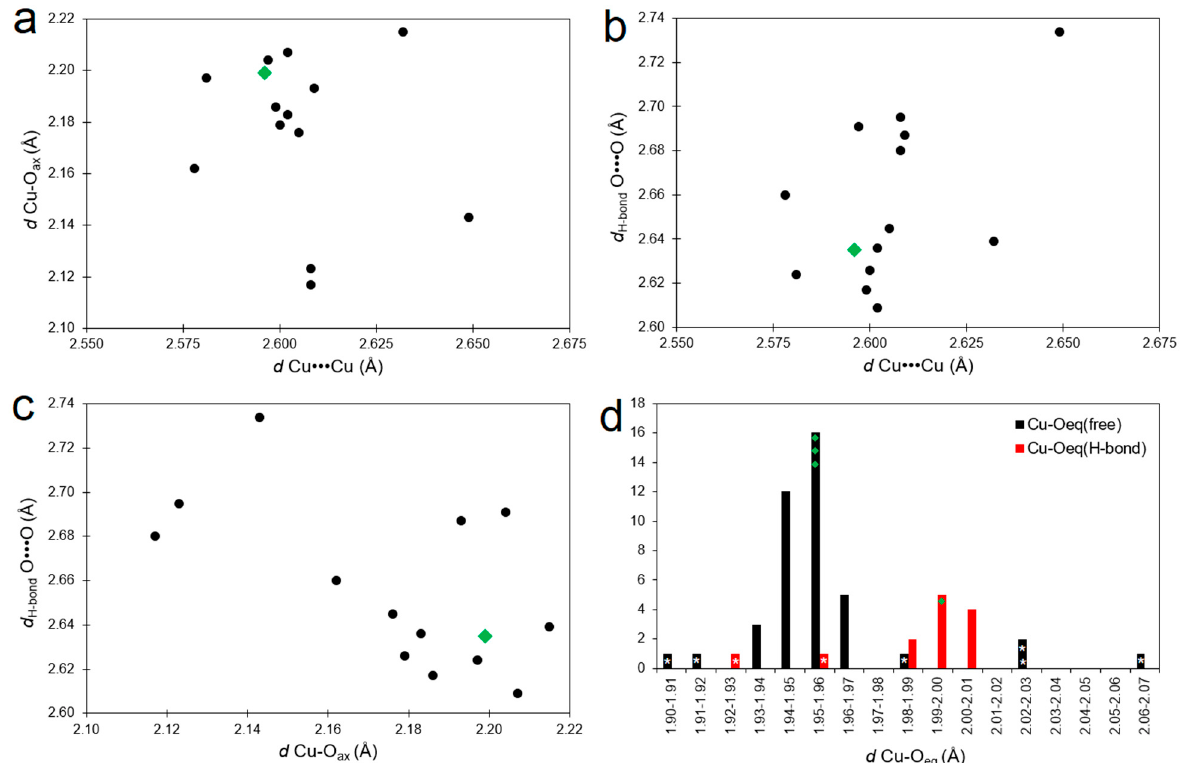
Figure 3. Scatterplots ( a – c ) and histogram ( d ) presenting relationships between selected structural parameters in [Cu 2 (A) 4 (HA) 2 ] compound group (CSD refcodes of included structures: ACACCV10, FAKRUE, GUGROP, KALQET, KIJKUJ, KUBHOE01, LATXEL, MODCOY, QIXGOU, ROZLUN, SUGHIL01, WEVWEZ). Green color indicates data of [Cu 2 (tig) 4 (tigH) 2 ]. White stars indicate data of [Cu 2 (triphenylacetate) 4 (triphenylacetic acid) 2 ] (CSD refcode: ROLZUN). For compounds, in which both copper cations are symmetry-dependent, one data set is presented. Two data sets are included only for ROZLUN, whose copper cations are not equivalent.